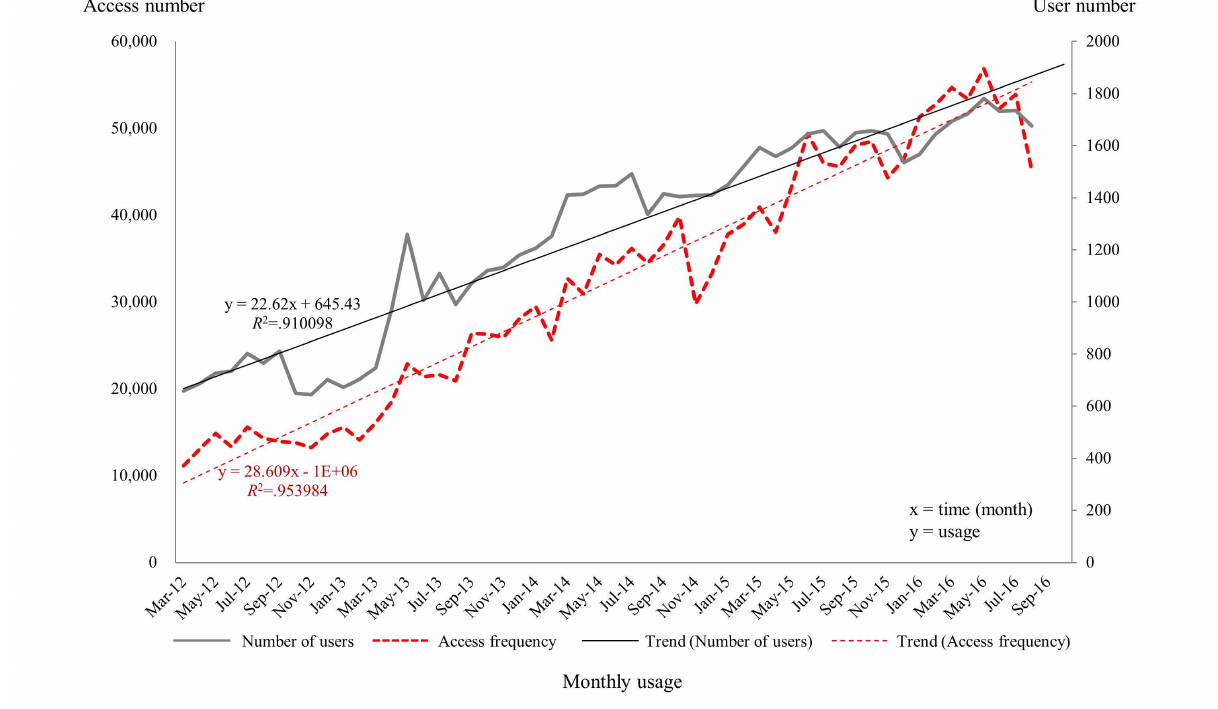
Figure 2. Monthly trends of the number of mobile Asan Medical Information System users and access frequencies from March 2012 to August 2016. The corresponding trend line and the correlation coefficient for usage per month present significant increases over